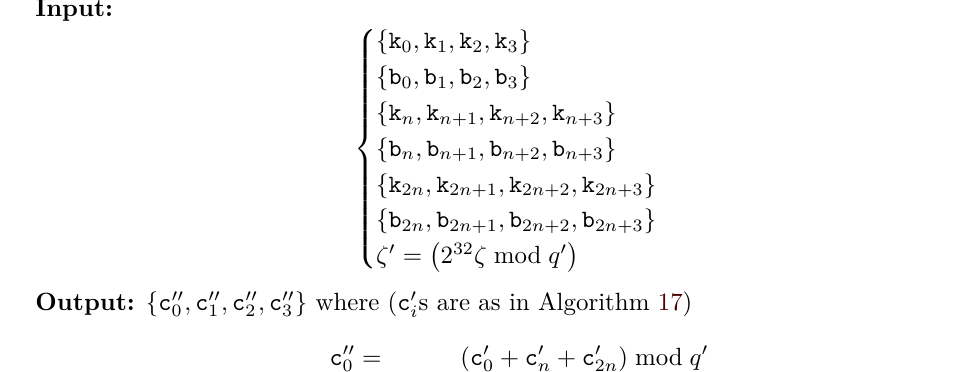
Algorithm 18 Saber 4 × 4 schoolbook refined ( l = 3 as an